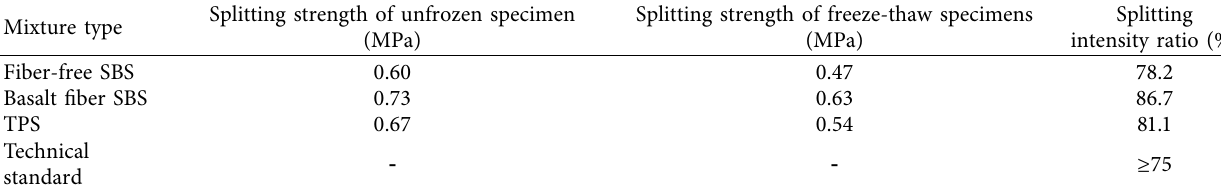
Table 14: Test results of freeze-thaw splitting.